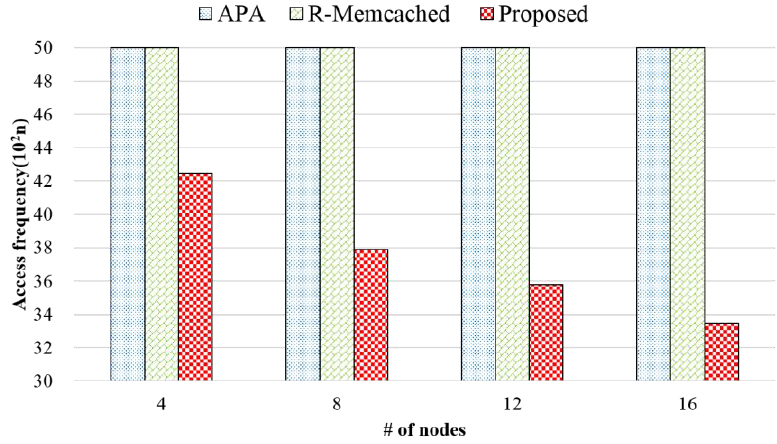
Figure 18. Load balancer access frequency according to the number of nodes.